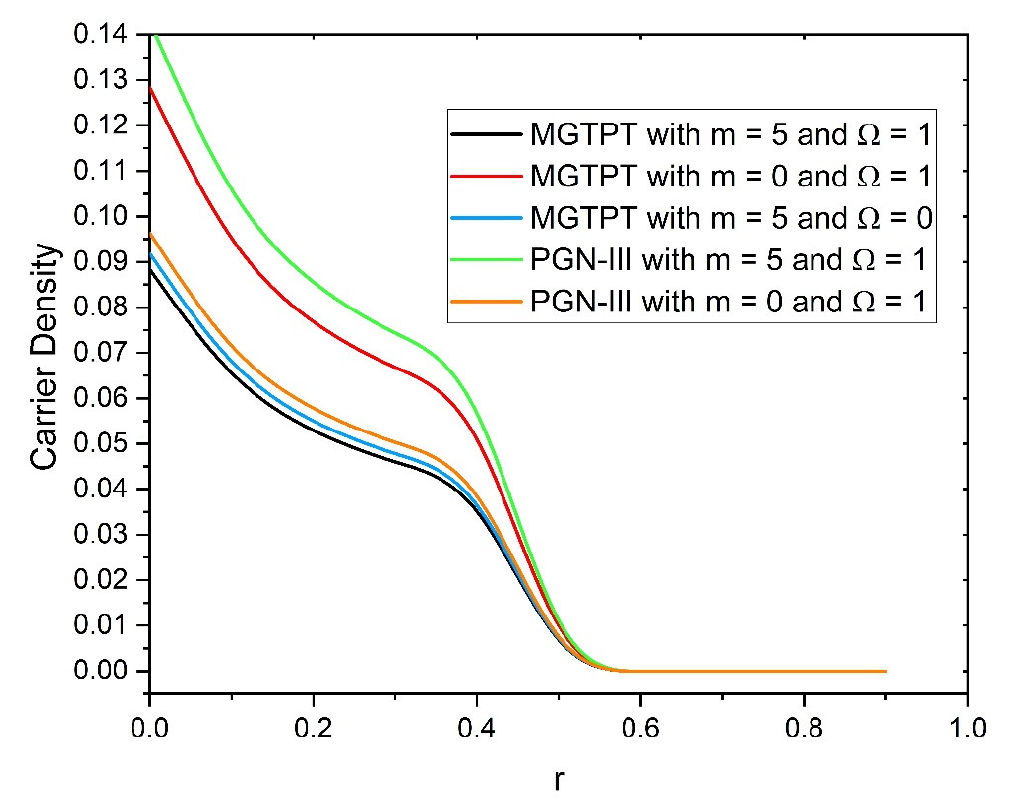
Figure 4. The variation in carrier density for various models with Hall effect and rotation.